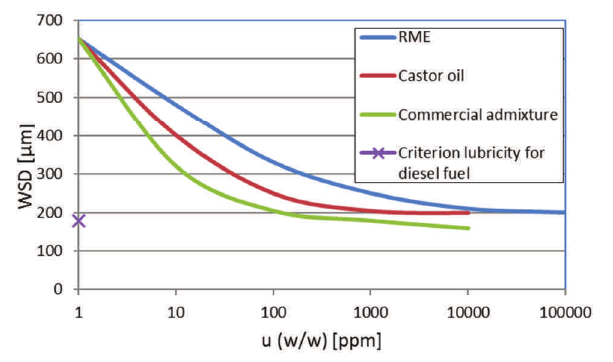
Fig. 1. Results of DME lubricity study – DME enriched with methyl esters of colza oil, castor oil and WSD (wear scad diameter)